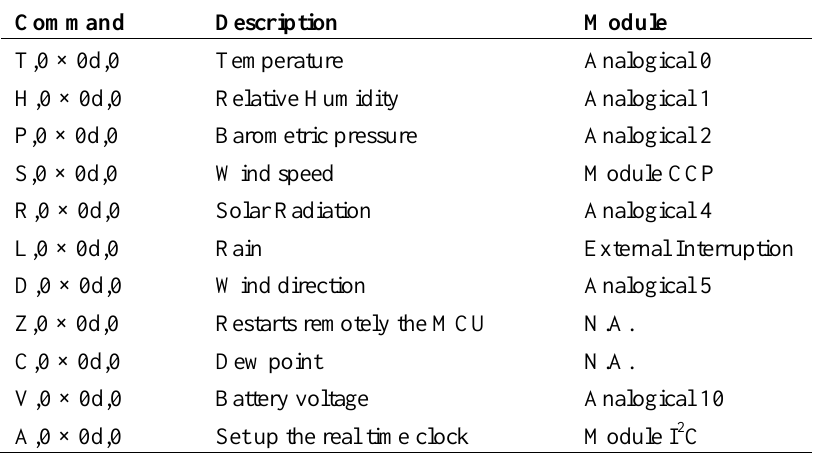
Table 1. List of commands decoded by the Remote Terminal Units.